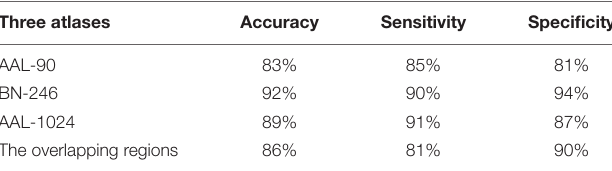
TABLE 2 | The classification performance of the proposed method on three atlases. Three